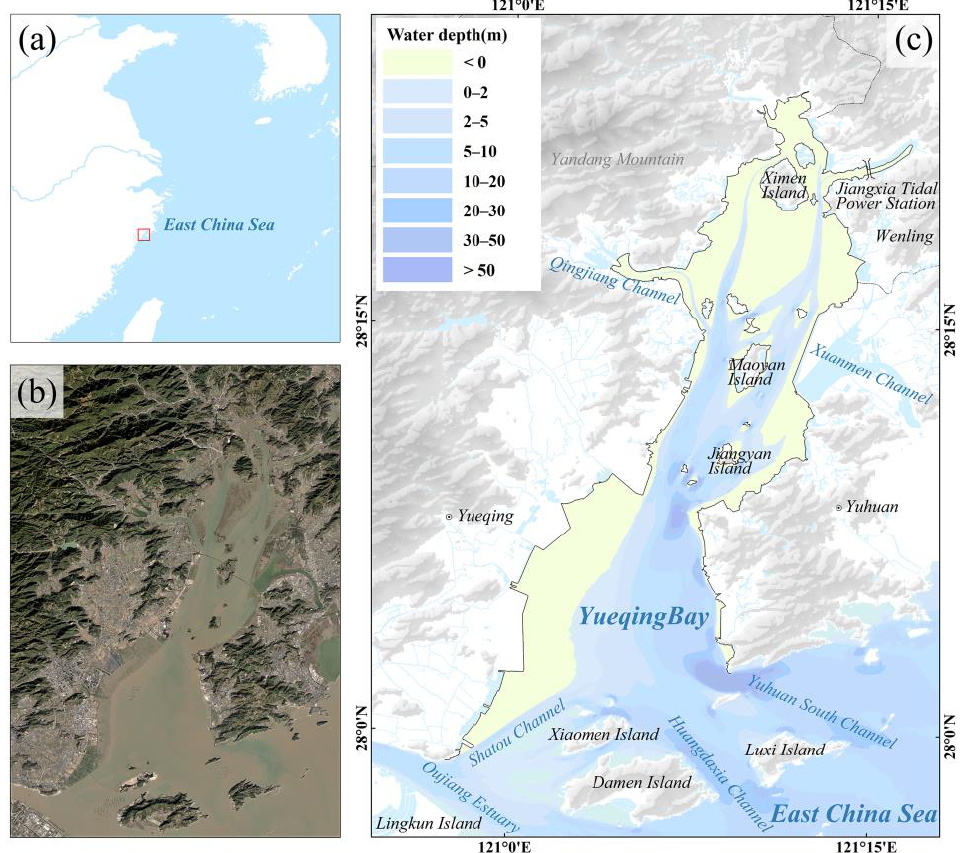
Figure 1. Map of the study area. ( a ) Location of the study area. ( b ) Landsat-8 images: 20 September 2021. ( c ) Topography of Yueqing Bay in 2021.